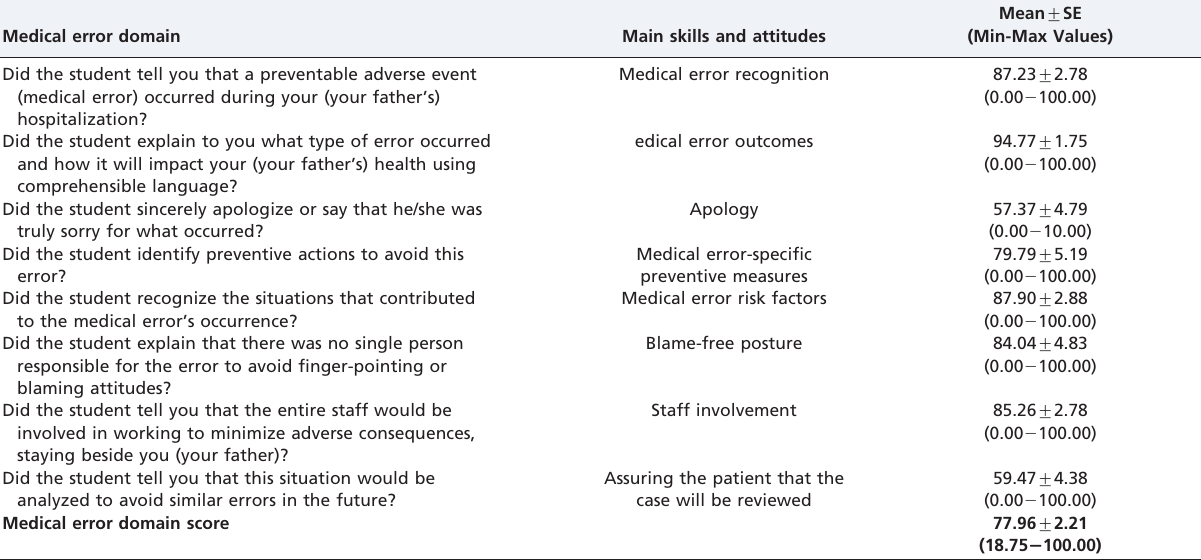
Table 2 - Patient safety checklist: medical error domain with the related competency and student scores. Medical error